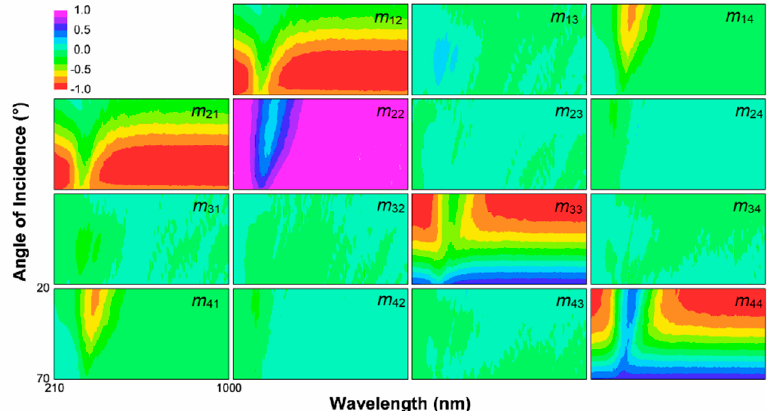
Figure 3. Contour map of the reflection Mueller matrix of a CNC glass ‐ supported film. Notice the reflection band with negative values in the m 41 element.